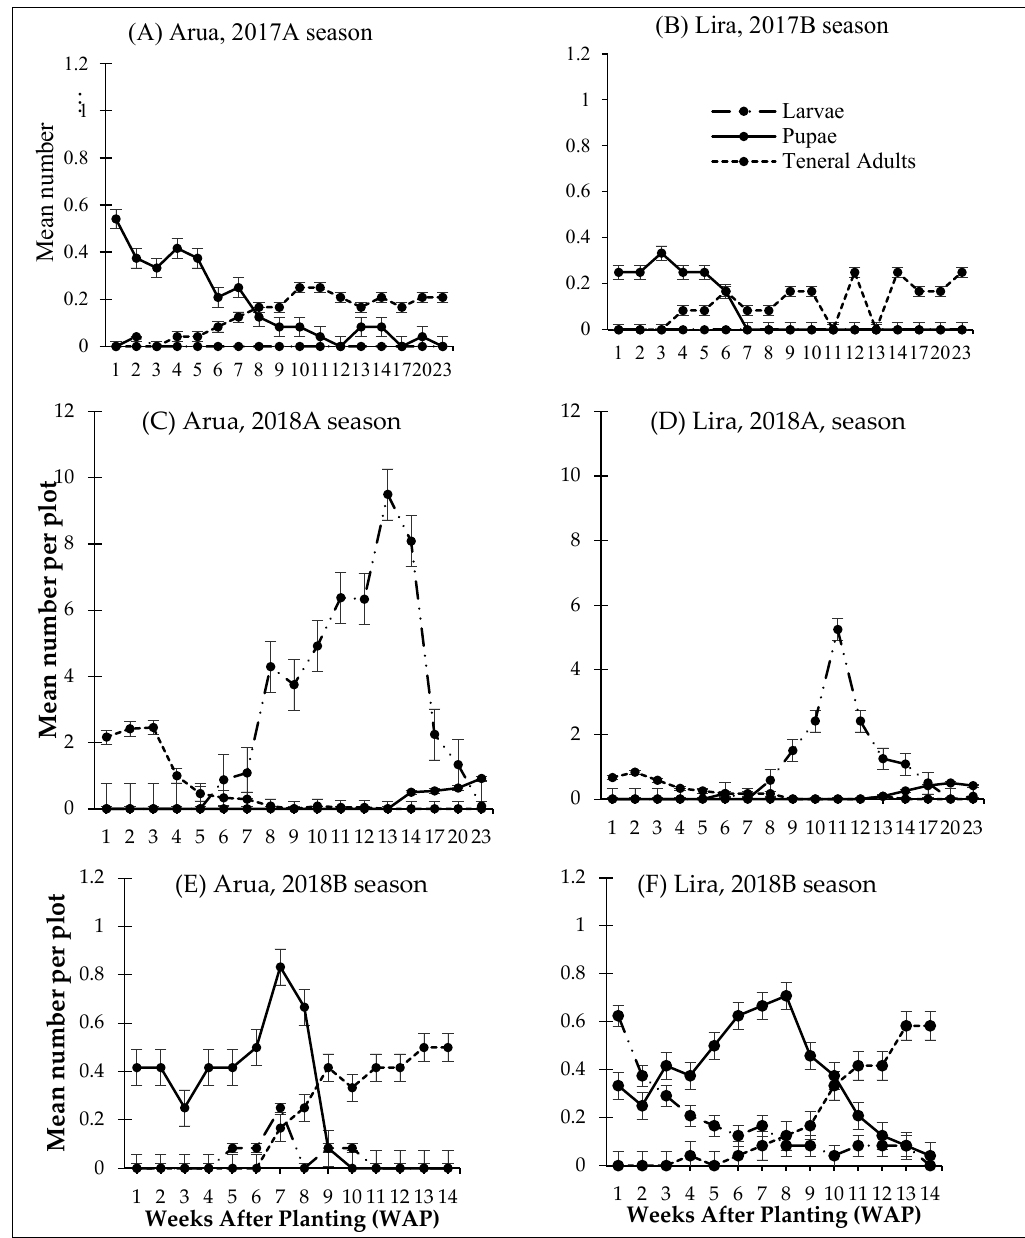
Figure 3. Abundance of below-ground Ootheca spp. life stages across three seasons in the Arua and Lira districts. Left column ( A , C , E )—Arua district; right column ( B , D , F )—Lira district. Top row: 2017B, middle row: 2018A, and bottom row: 2018B season.